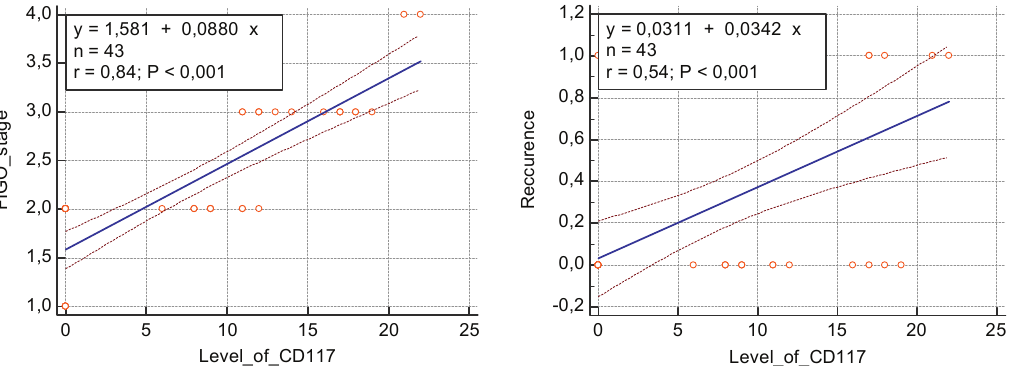
Fig. 3. Graphic representation of the relationship between CD44 expression and disease stage (left) and relapse (right)